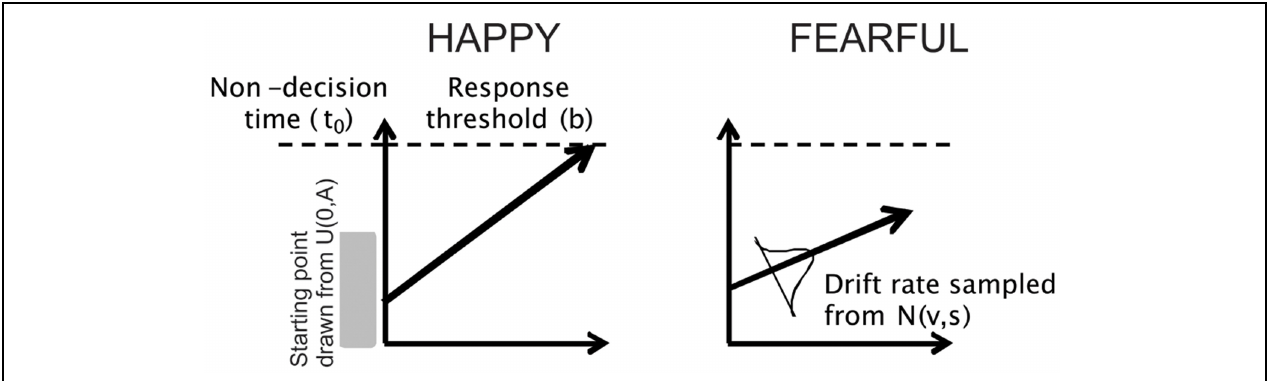
FIGURE 2 | Schematic of the LBA model. The 5 parameters of the model are: (1) drift rate (which corresponds to the rate of sensory evidence accumulation or perceptual processing efficiency of the participant); (2) standard deviation (which corresponds to how much drift rates can vary across trials); (3) starting point (starting amount of evidence before the decision process begins); (4) response threshold (how much evidence is needed before making a choice); and (5) non-decision time (time unrelated to the decision process, such as sensory processing or response execution). The two racing accumulators begin with a random activation level (the starting point) that is independently drawn from a uniform distribution (indicated by the shaded gray area) on [0, A], where A is a free model parameter. Activity in each accumulator increases linearly, and a response is triggered as soon as one accumulator reaches the response threshold ( b ). Time is indicated on the abscissa and so the predicted RT is the time taken to reach the threshold, plus a constant offset that represents time unrelated to the decision process (non-decision time, t 0 ). The rate at which activation increases in each accumulator is termed the drift rate ( v ). On each trial, the drift rates are drawn from two independent normal distributions ( v , s ). In this example, a subject may need to decide if a face is HAPPY or FEARFUL. The LBA models this two-choice perceptual decision as a race between two “accumulators” that accrue sensory evidence in favor of each choice over time. The first accumulator to gather the criterion amount of evidence determines the subject’s choice and RT (equivalent to the time taken for the accumulator to hit the response threshold plus non-decision time to account for sensory and motor processing time). In the example shown here, the accumulator for “HAPPY” hits the response threshold first, thereby the model predicts the perceptual decision to be a happy face. For more details, see Brown and Heathcote